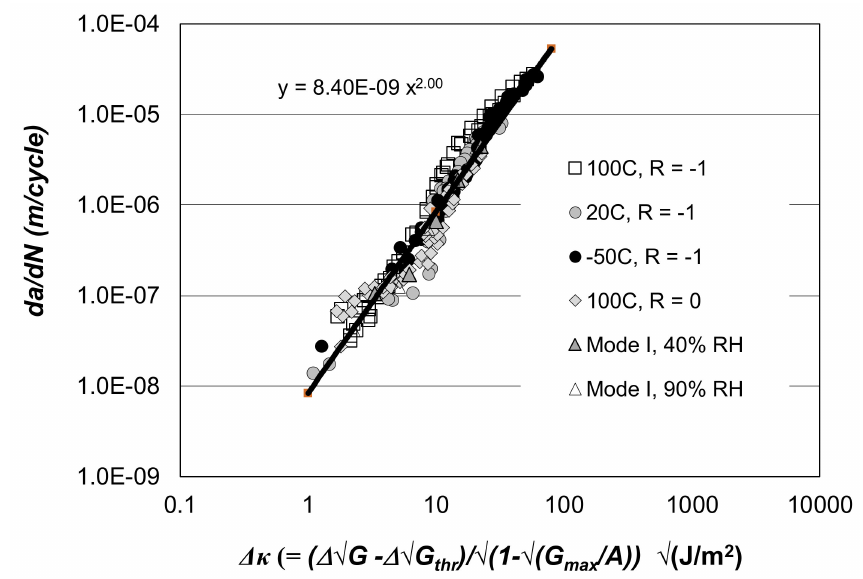
Figure5. The da / dN versus ∆ κ relationshipforModeIIandModeIfatiguecrackgrowthin“FM300K”[60]. (ModeIIfailureunlessotherwisestated. Where ∆ in the fatigue cycle, as defined by ∆